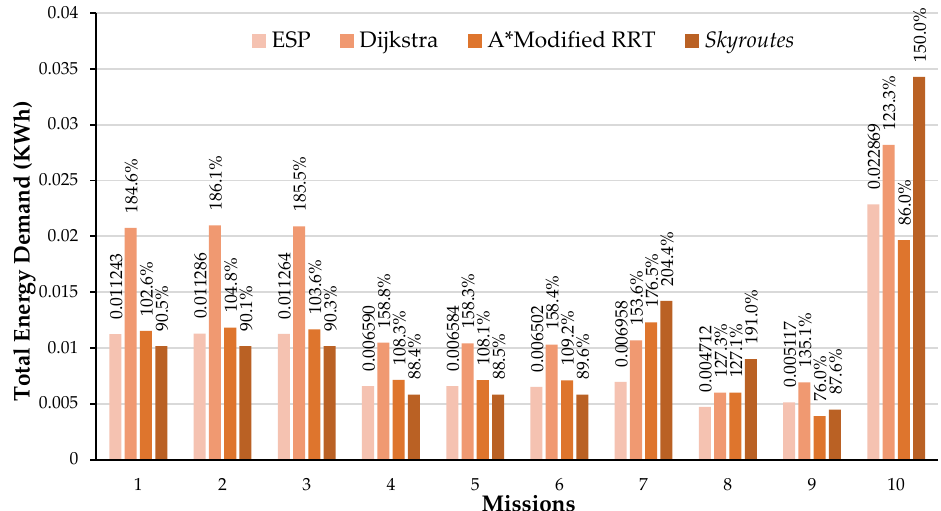
Figure 13. UAV Thrust comparison for mission one.